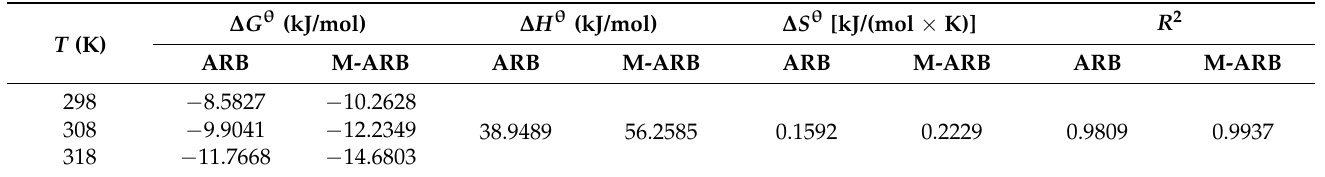
Table 5. Adsorption thermodynamic parameters of MB onto ARB and M-ARB.